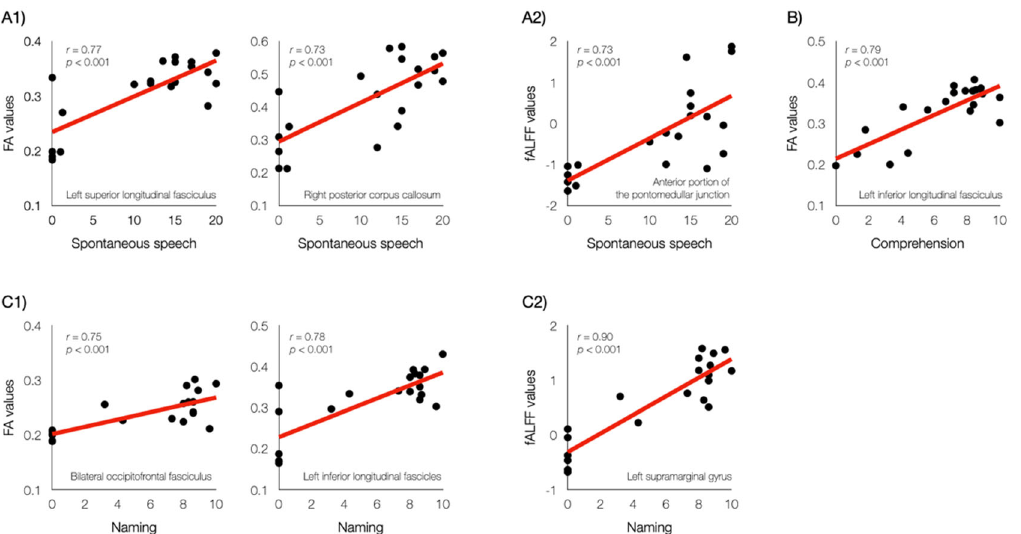
Figure 4. Relationships between regional neuroimaging values and language scores. ( A1 ), positive association between regional fractional anisotropy (FA) values and spontaneous speech; ( A2 ), positive association between regional fALFF values and spontaneous speech; ( B ), positive association between regional FA values and comprehension; ( C1 ), positive association between regional FA values and naming; ( C2 ), positive association between regional fALFF values and naming.